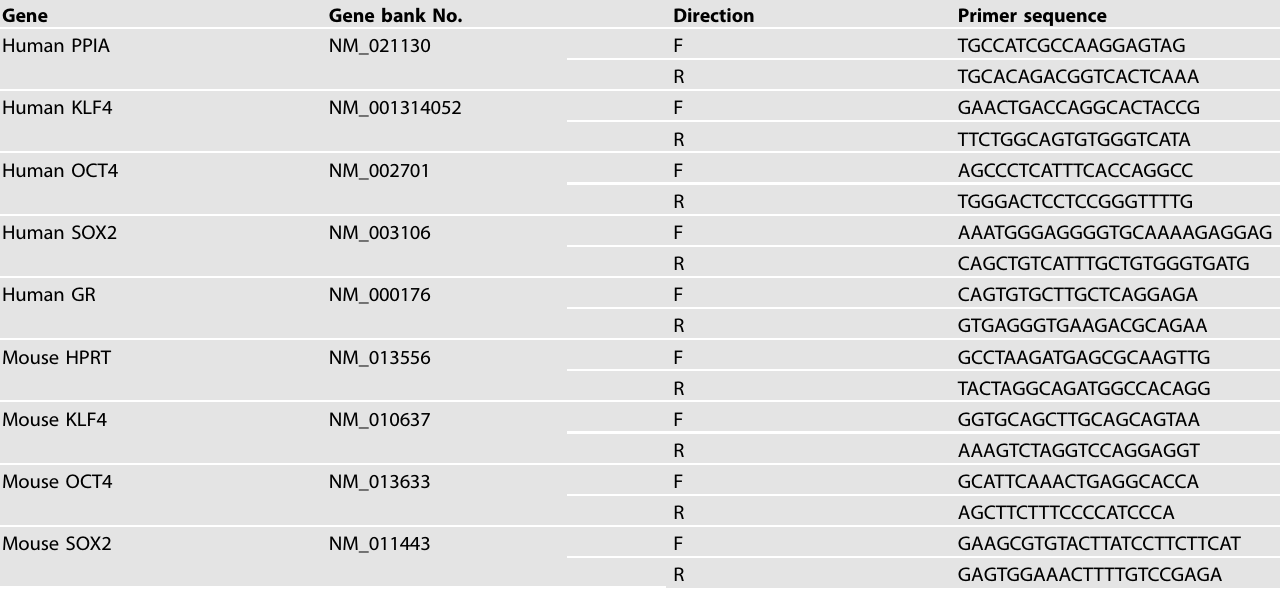
Table 1. Primer sequences for quantitative